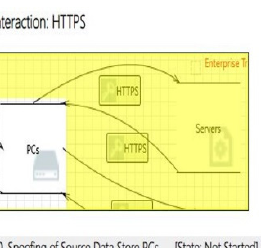
Figure 7. A portion of the MTMT report.